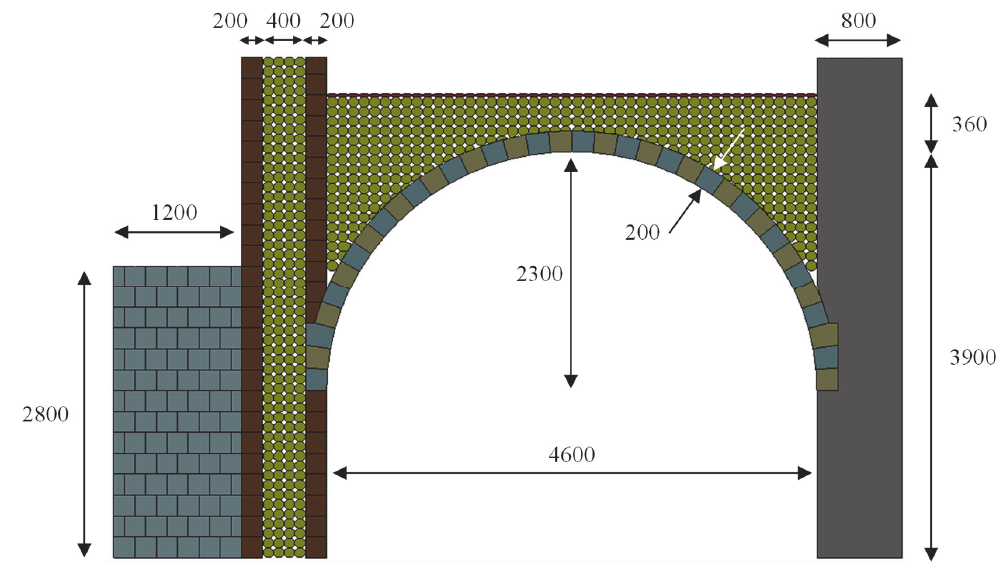
Figure 4: Geometry of the FEM